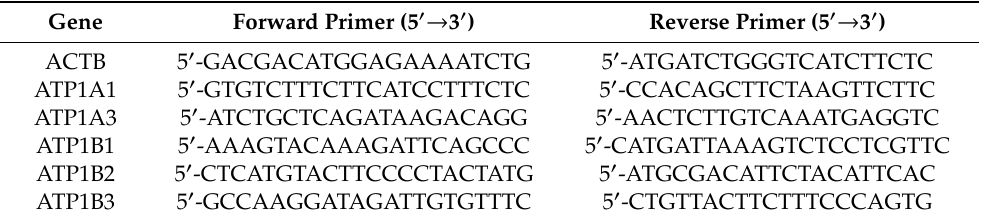
Table 1. Pre-designed primers (Sigma-Aldrich; Milan, Italy) for qPCR analysis of genes encoding for the di ff erent isoforms of α (1 and 3) and β (1, 2 and 3) subunits of the Na + / K +